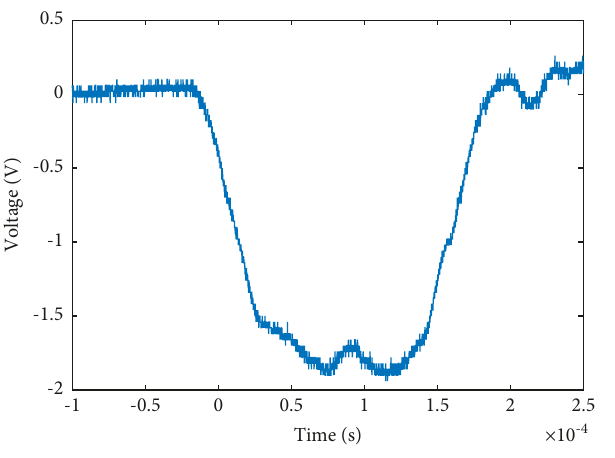
Figure 5: Unshaped incident